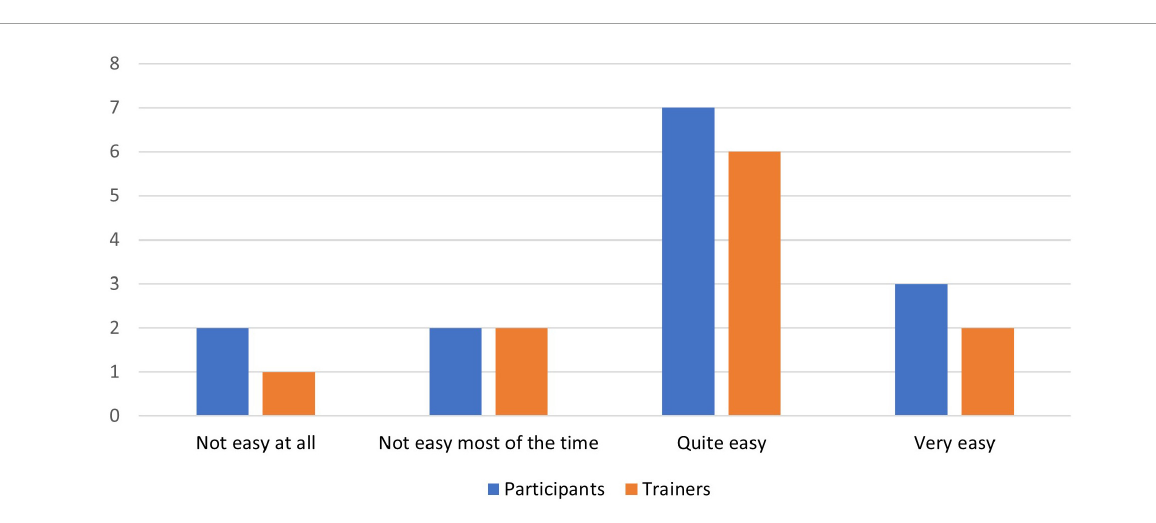
participants during COVID-19 pandemic period, which helped in the execution of